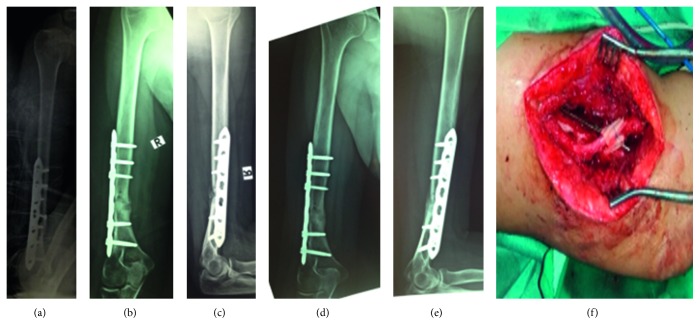
(a) X-ray after the initial treatment of the humerus fracture with a dynamic compression plate. (b and c) X-ray after the nonunion treatment. (d and e) X-ray 3 months postoperatively showing callus formation in the previous nonunion site. (f) Intraoperative picture after the nonunion treatment showing the radial nerve.